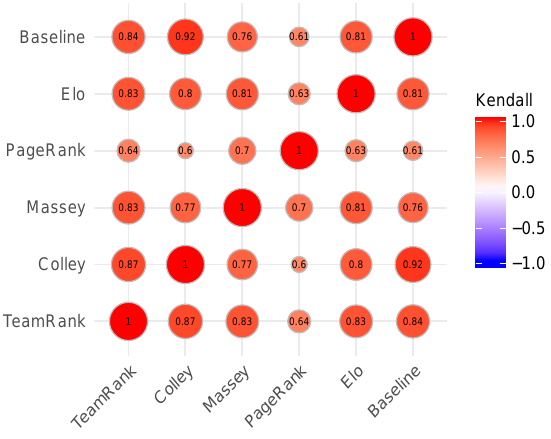
Figure 2. Kendall correlation matrix for different models’